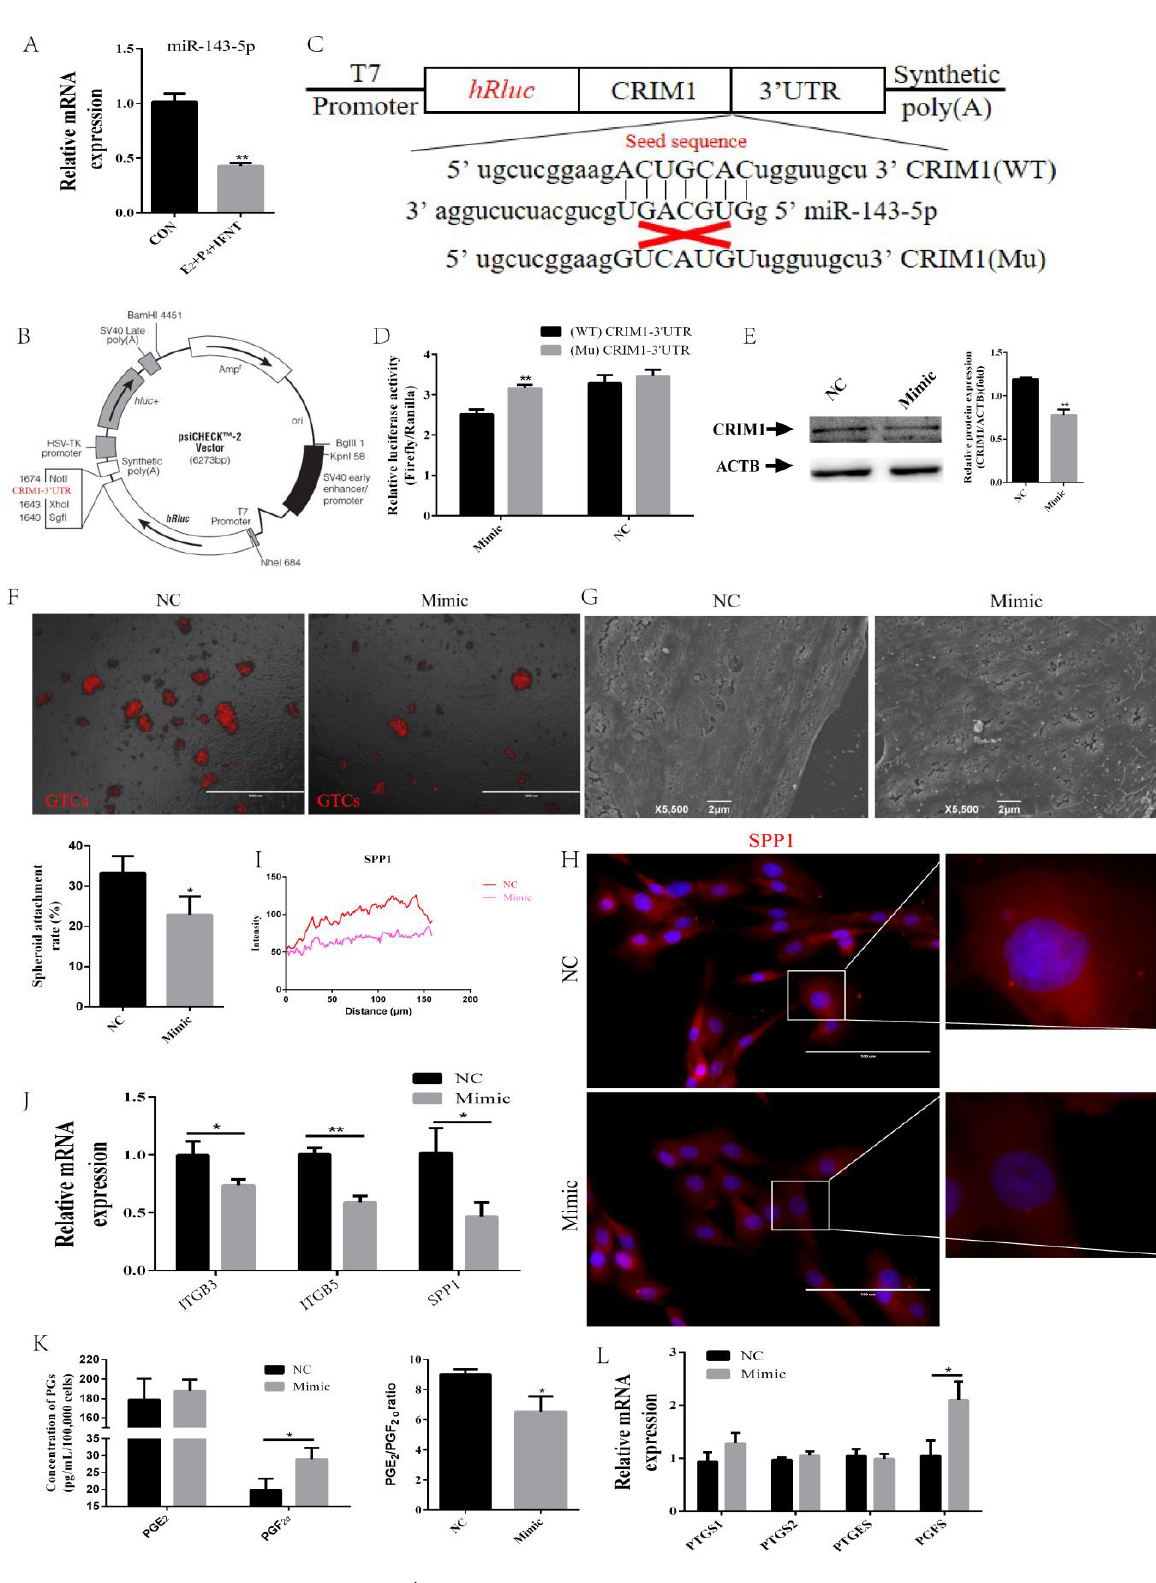
Figure 6. miR-143-5p targeted the CRIM1 3 (cid:48) UTR to regulate endometrial receptivity. ( A ) The effect of P 4 , E 2 and IFN- τ on the expression levels of miR-143-5p. ( B ) The psiCHECK TM -2 vector map and the insertion site of CRIM1-3 (cid:48) UTR are marked in red. ( C ) Schematic diagram illustrating the design of luciferase reporters with the WT-CRIM1 3 (cid:48) UTR (WT-CRIM1) or the site-directed mutant CRIM1 3 (cid:48) UTR (Mu-CRIM1). The nucleotides in red represent the “seed sequence” of